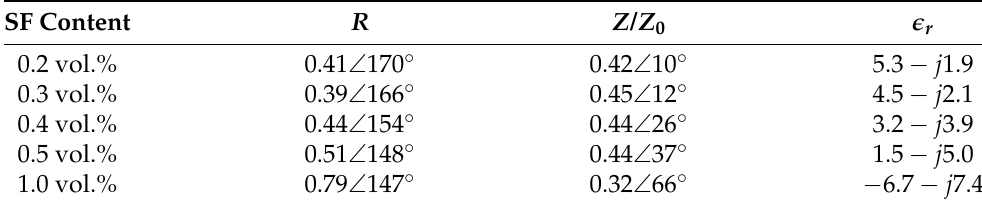
Figure 11. Reflection and impedance in complex planes. ( a ) Reflection. ( b ) Impedance. Table 1 shows the measured values of each specimen at the center frequency 10.3 GHz. Table 1. The result of the measured reflection, impedance, and permittivity of the SFRC at the center frequency (10.3